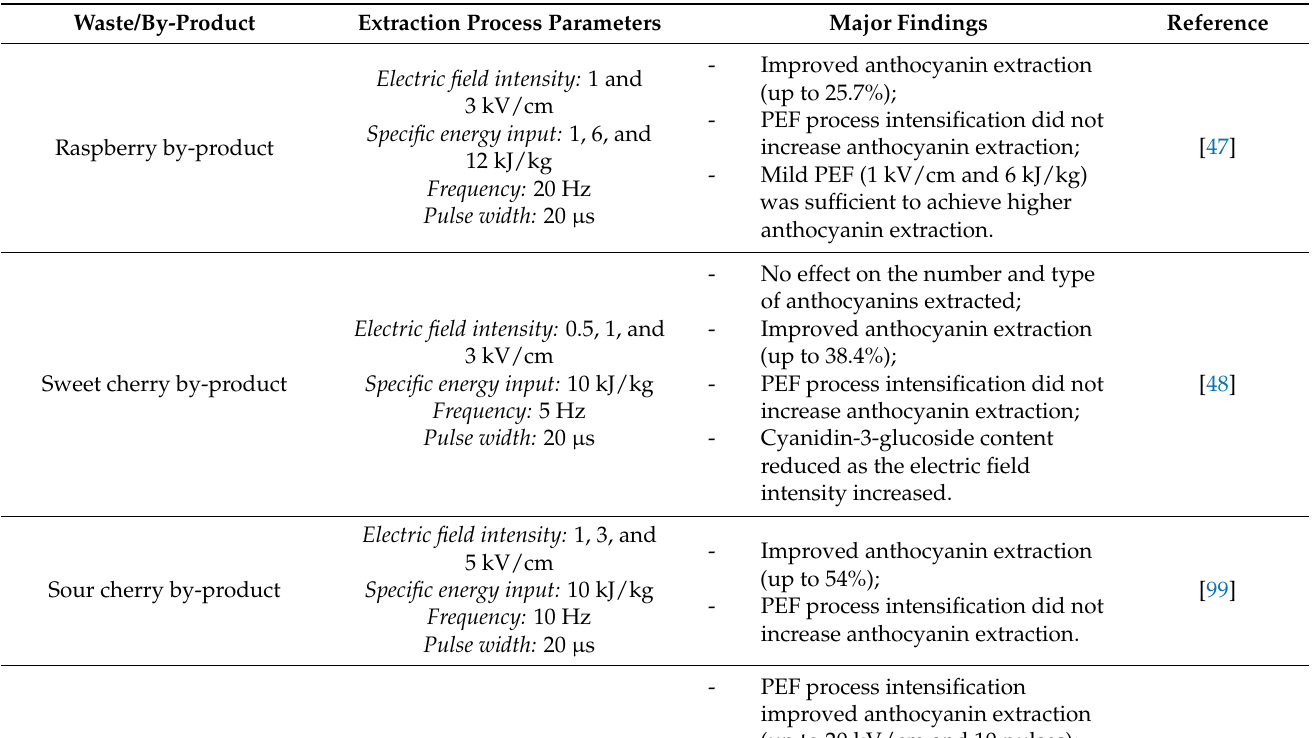
Table 2. Summary of the main recent findings showing the effects of the pulsed electrical field (PEF) technology on anthocyanin extraction from agri-food